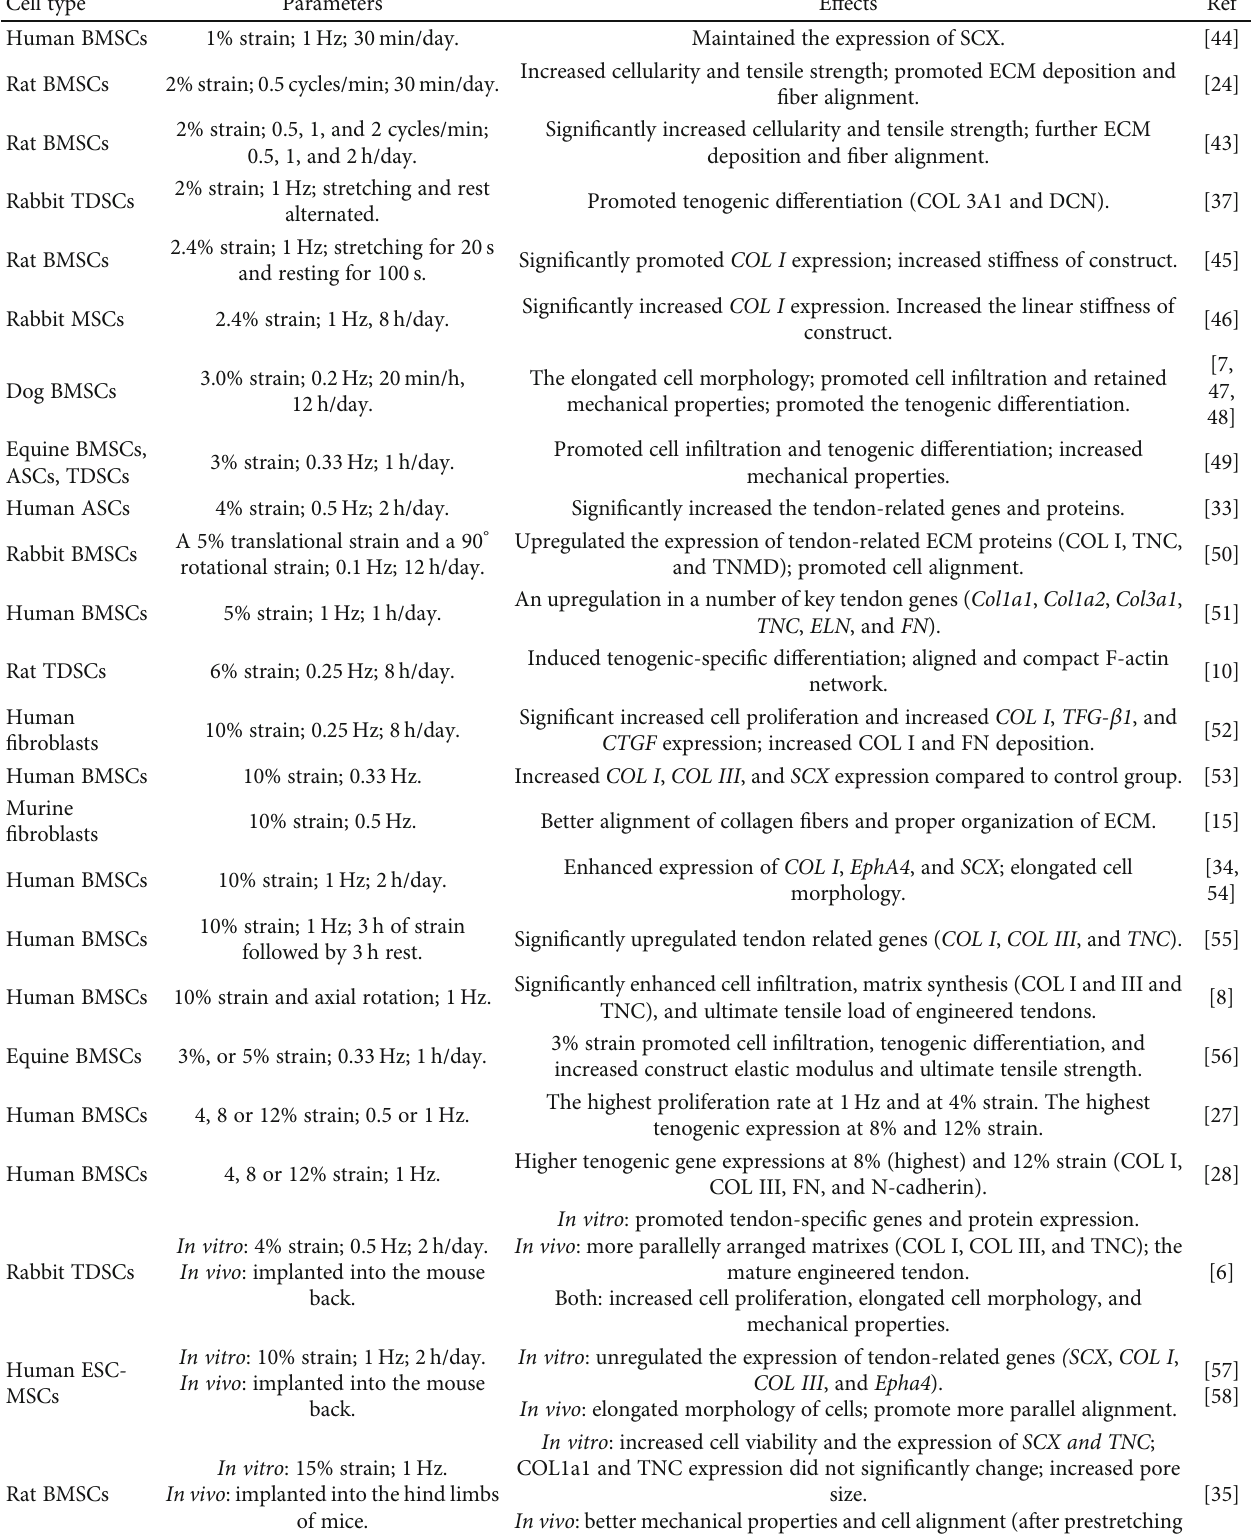
Table 1: Dynamic uniaxial stretching used in tendon tissue